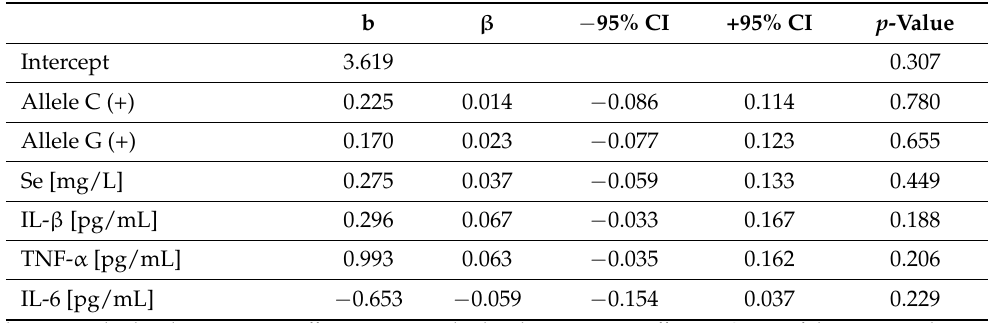
Table 14. Model without moderation.